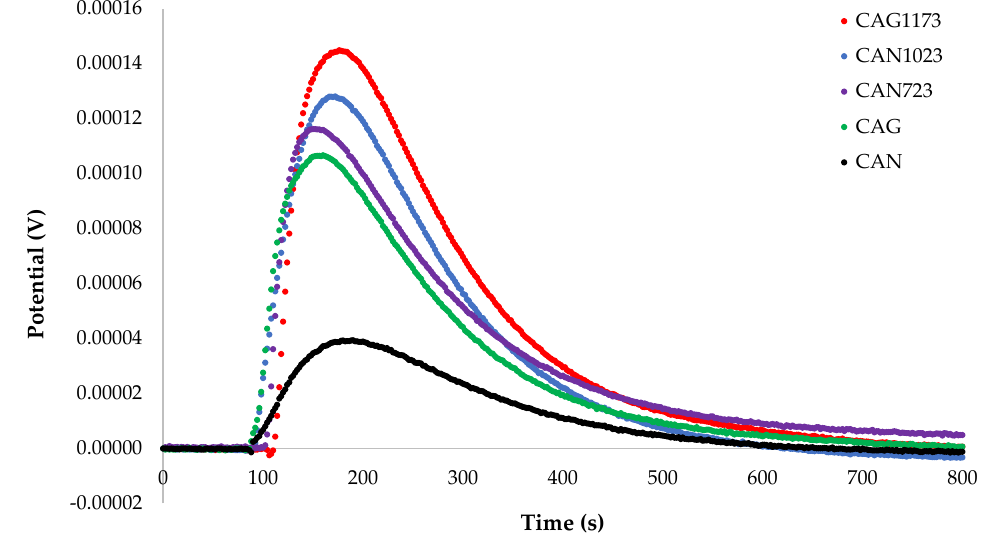
Figure 2. Curves of electric potential as a function of the immersion time of activated carbons in cyclohexane.